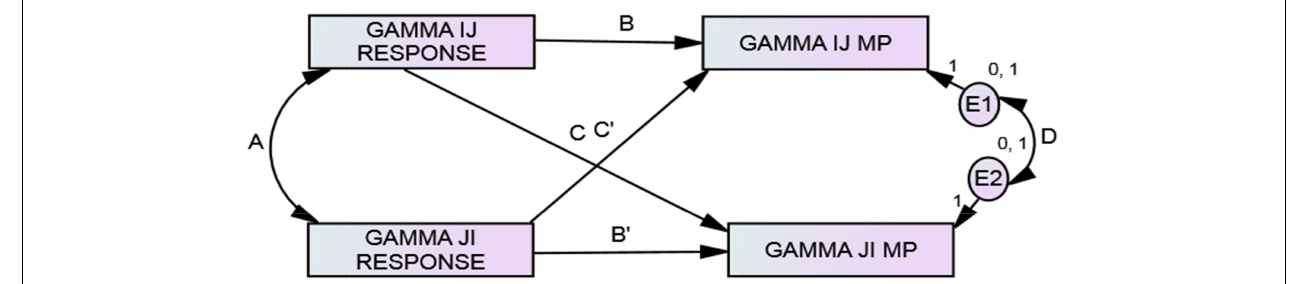
FIGURE 5 | Full dyadic ARRMA model with distinguishable dyad members.